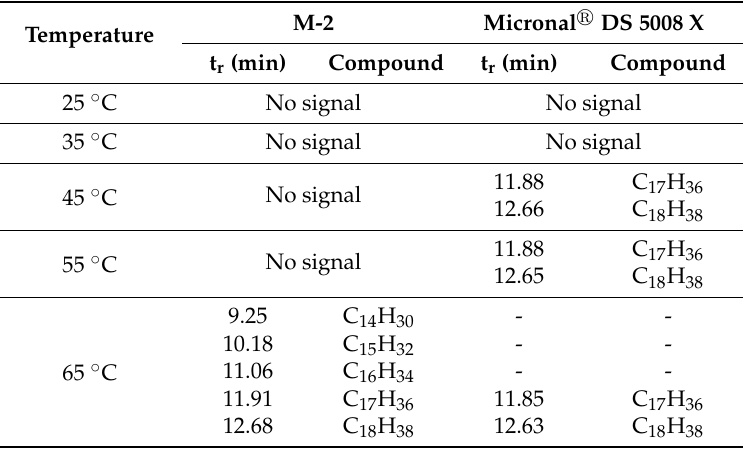
Table 3. VOC emission results for M ‐ 2 and Micronal ® DS 5008 X samples.